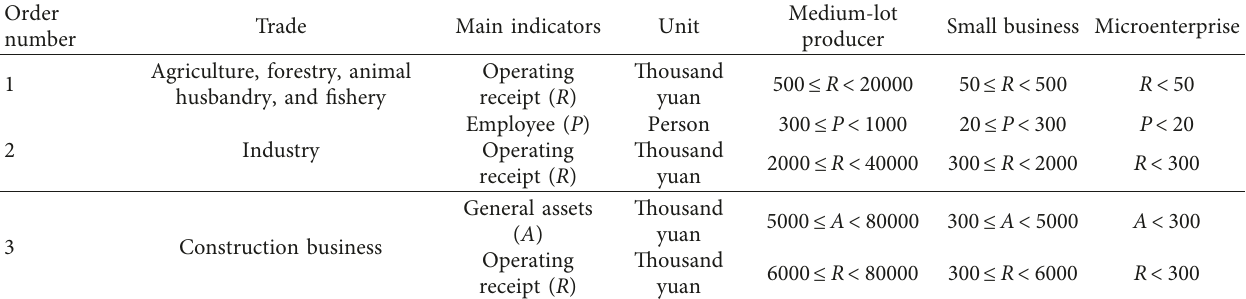
Table 1: Appraisal standards for small- and medium-sized